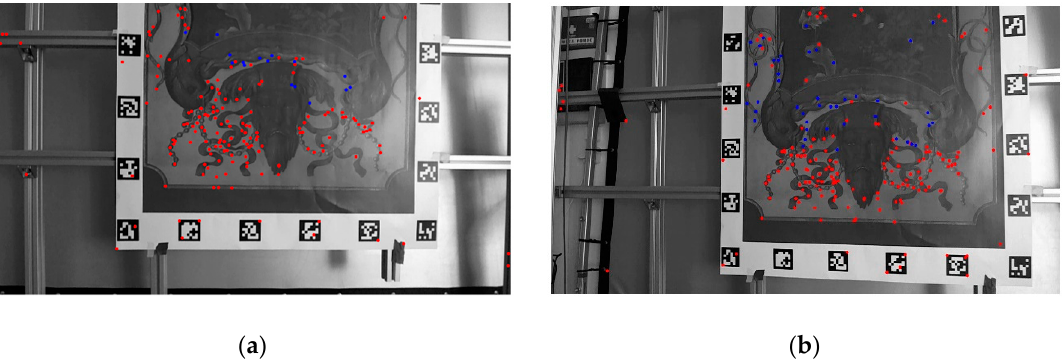
Figure 15. Point distribution: blue—inliers; red—outliers. ( a ) Non-uniform inliers are located only on a part of an image. ( b ) Uniform point distribution.